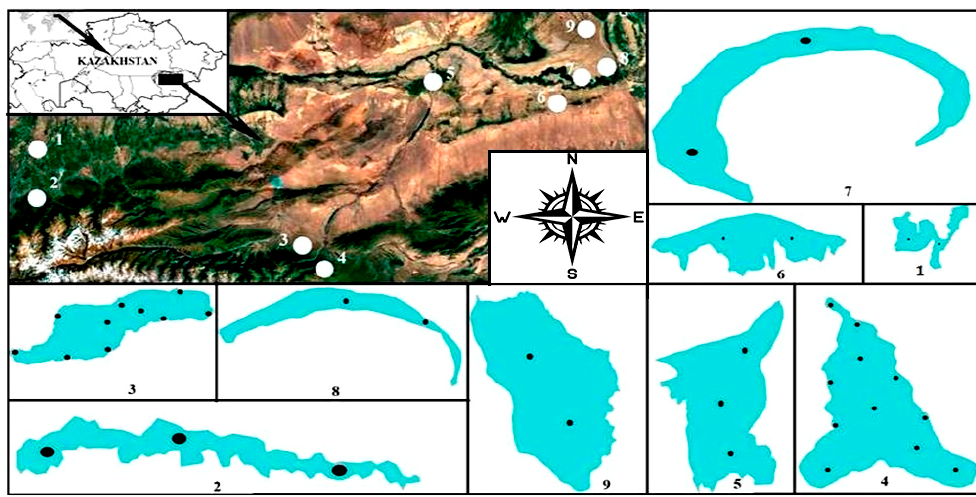
Figure 1. Map—scheme of small lakes in South-East Kazakhstan: 1—Ali, 2—Pervomaika, 3—Lower Kolsay, 4—Middle Kolsay, 5—Derevyannoe, 6—Kosagash, 7—Bolshaya Podkova, 8—Malaya Podkova, 9—Altynkol. Lower Kolsay and Middle Kolsay Lakes are located in Kungey Alatau mountain; the rest of the lakes are at lower altitude. All of them belong to the Ili-Balkhash water basin. The surveyed lakes have a small water surface (Table 1). Lower Kolsay and Middle Kolsay are the deepest, with high transparency and low water temperatures. The river of the same name feeds them. Macrophytes do not develop. Among the plain lakes, Derevyannoe and Pervomaika are the deepest. All lakes at lower altitude are warm, with relatively low water transparency, are overgrown with macrophytes to varying degrees. Their water supply sources are groundwater, except for Lake Pervomayka, which is filled with water from the small river Karateren. Table 1. Physical and geographical characteristics of small lakes in South-East Kazakhstan, summer 2019. Altitude Lake above Altitude Name Lake Name